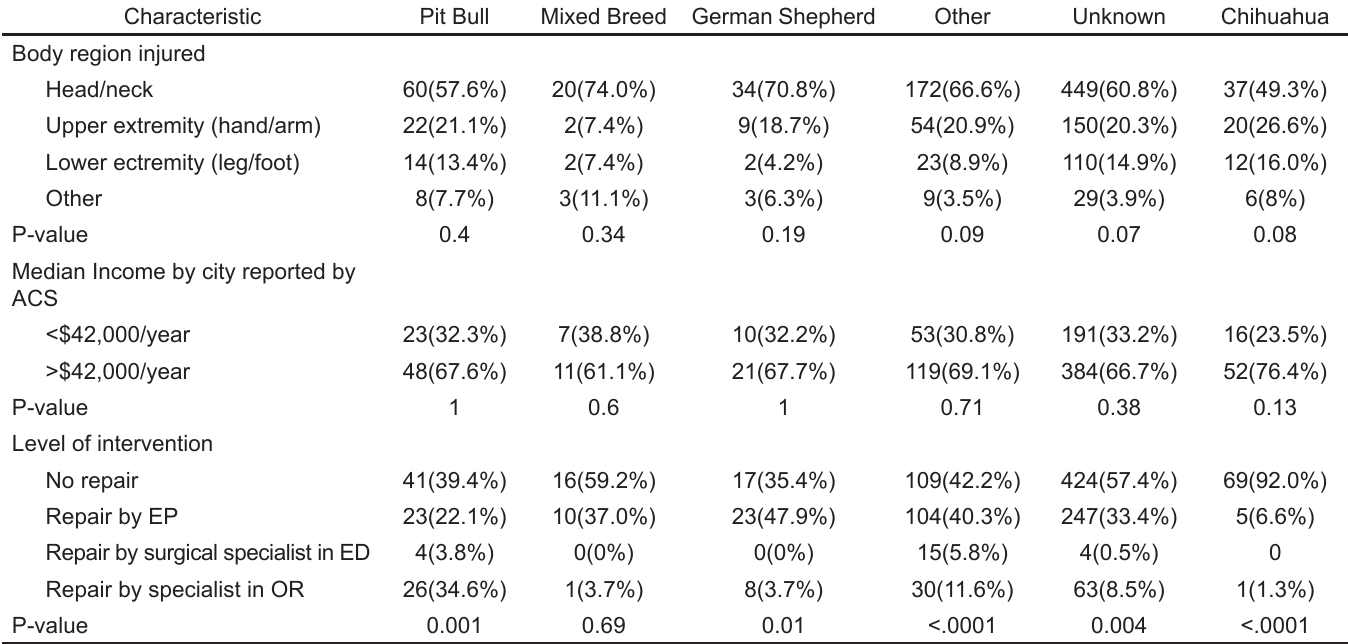
Table 4. Dog-bite visits by breed of dog from 2013–2018.